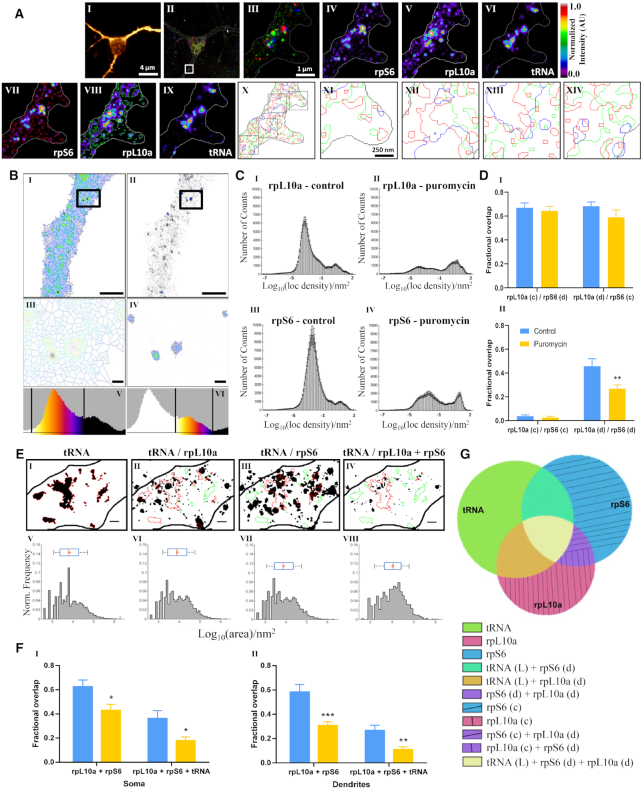
A fraction of fluorescently labeled tRNA is associated with the assembled ribosome as measured in neurons by single molecule based localization microscopy (SMLM). (A) Nanoscale organization of translation. (I) Map2-positive neuron; (II) SMLM of rpS6 (red), rpL10a (green) and tRNA (blue); (III) magnification of ROI in a dendrite; (IV) rpS6; (V) rpL10a; (VI) tRNA; (VII–IX) Semi-automated detection of signals differently outlined for staining of rpS6, rpL10a, and tRNA; (X) 3-color overlay of the segments obtained in VII-IX; (XI-XIV) magnification of 4 ROI in picture X. (B) Ribosomal proteins can be separated into two sub-populations based on localization density. (I–II) Diffuse (I) and clustered (II) regions of rpL10a in a representative dendrite. (III–IV) Magnification of ROI of diffuse (III) and clustered (IV) rpL10a. (V–VI) Distribution diagrams of density of localizations of rpL10a labeling. Vertical lines define the boundaries of the diffuse (V) and clustered (VI) regions. Scale bars: 2 μm, 250 nm. Diffuse: ≤ 40 localizations per nm2; clustered: ≥40 localizations per nm2. (C) Puromycin treatment leads to a decrease in diffuse pools of rpL10a and rpS6(I) Distribution of localization density of rpL10a under basal conditions. Total number of counts = 1 268 723. (II) Puromycin treatment. Total number of counts = 536 530. (III) Distribution of localization density of rpS6 under basal conditions. Total number of counts = 2 056 885. (IV) Puromycin treatment. Total number of counts = 765 686. Loc = localizations (D). Puromycin treatment leads to decreased overlap of diffuse pools of rpL10a and rpS6 only. Fractional overlap between (I) clustered rpL10a and diffuse rpS6, and clustered rpS6 and diffuse rpL10a, and (II) clustered rpS6 and rpL10a, and diffuse rpS6 and rpL10a, under basal conditions and after addition of puromycin. n = 15 different captured regions from three biologically independent repeats. ** P < 0.01 (E). Larger tRNA puncta more commonly associate with L10a and rpS6 than smaller puncta. (I) ROIs of thresholded tRNA puncta. (II–IV) Transfer of ROIs from I to rpL10a, rpS6 and the overlapping regions of rpL10a and rpS6, respectively. Red = overlap, green = no overlap. Scale bar: 500 nm. (V) Logarithmic scale plot of total area of tRNA. Mean = 7079.5 nm2, SD = 4.07 nm2, median = 6025.6 nm2, IQR 2398.8–19054.6 nm2; (VI–IX) Logarithmic scale plots of total area of overlap in II–IV, respectively. (VI) Mean = 8317.6 nm2, SD = 4.07 nm2, median = 7585.8 nm2, IQR 2818.4–25118.8 nm2; (VII) Mean = 7943.3 nm2, SD = 4.17 nm2, median = 7244.4 nm2, IQR 2754.2–22387.2 nm2; (VIII) Mean = 10715.2 nm2, SD = 3.72 nm2, median = 11481.5 nm2, IQR 3981.1–25118.9 nm2. Blue bars = distribution of the tRNA puncta sizes. Red vertical lines = median; plus signs = mean of the distribution. (F) Puromycin treatment reduces the association of rpL10a, rpS6 and tRNA. Fractional overlap of rpL10a and rpS6 alone and together with tRNA puncta in (I) somata and (II) dendrites under basal conditions and following puromycin application. n = 22 different captured regions (somata) and 14 different captured regions (dendrites) from three biologically independent repeats. * P < 0.05; ** P < 0.01; *** P < 0.001 (G). A schematic summary of results. Diffuse fractions of rpL10a and rpS6 are found to overlap with each other as well as with large tRNA puncta, whereas clustered regions of rpL10a and rpS6, as well as small tRNA puncta, are not found to be in co-localization.